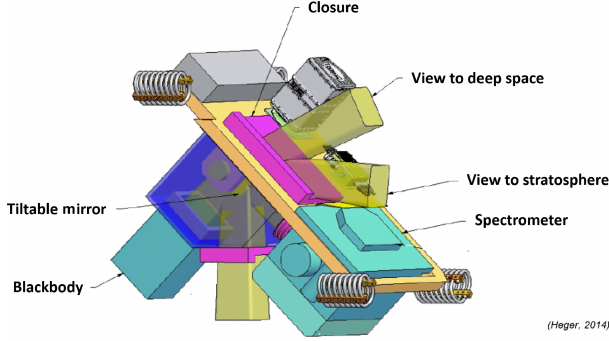
Figure 1. Schematic of the GLORIA balloon instrument. Table 1. Requirements for the large-area blackbody